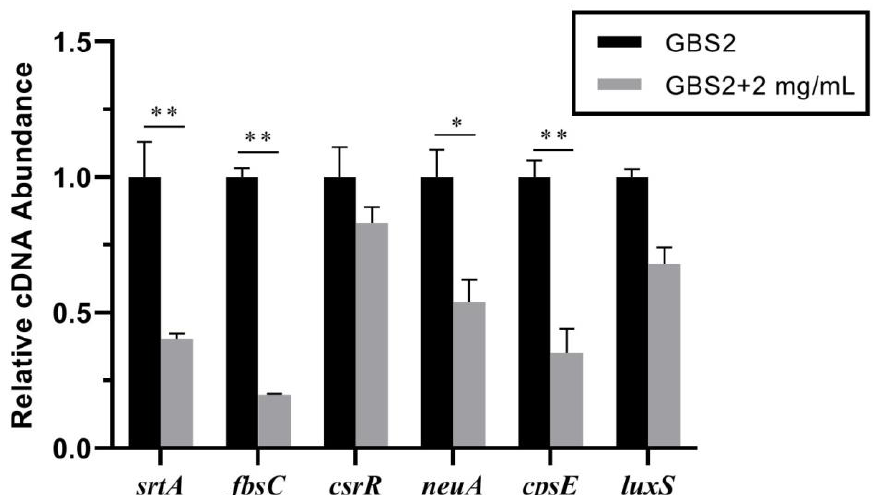
Figure 4. Transcript levels of the biofilm-associated genes determined by RT-qPCR. The transcription of srtA , fbsC, csrR , neuA , cpsE, and luxS were measured in GBS2 without or with 2 mg/mL TS. The differences of gene expression were calculated by ΔΔCt (Ct = cycle threshold) method using the 16S rDNA gene as the housekeeping gene, normalized by subtracting the Ct value of 16S cDNA from target cDNA. All experiments were repeated at least three times with four parallels (* represents p < 0.05 and ** represents p < 0.01). Error bars indicate standard deviations.